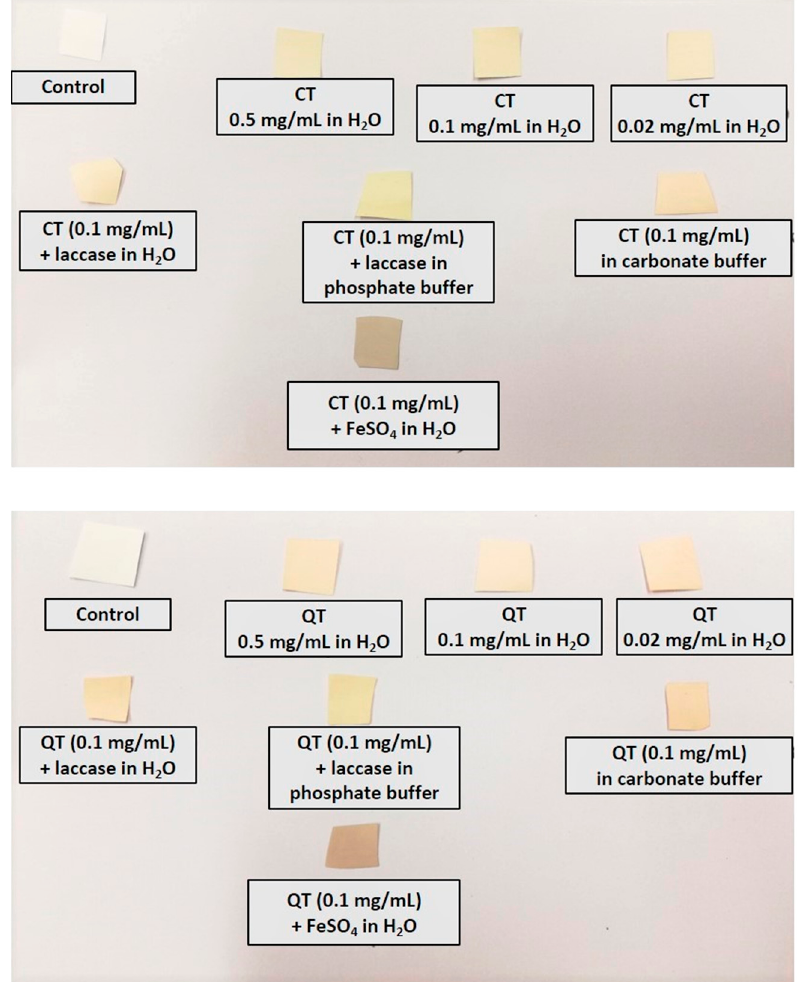
Figure 3. Nylon membrane filters coated with chestnut tannins (CT) ( top ) and quebracho tannins (QT) ( bottom ) under the different dip coating conditions explored.